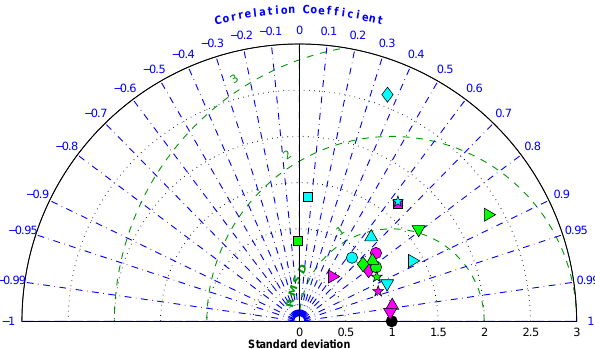
Fig. 2. Taylor diagram of non-area weighted statistical summary be- tween the simulated and observed annually averaged (climatology) of ( 5 ) ocean temperature, ( B ) salinity, ( ? ) phosphate, ( 4 ) dissolved oxygen, ( (cid:13) ) silicate, ( ♦ ) dissolved inorganic carbon, and ( (cid:3) ) al- kalinity. Shown here are comparison at surface (magenta), 1000m (blue), and 3000m (green) depths. Observations are based on the World Ocean Atlas (WOA) and GLODAP (see also text). The black circle represents the observations. All standard deviations are nor- malized to the respective observed standard deviation. For tempera- ture, salinity, phosphate, silicate and oxygen, we compare the HIST simulation from 1980–1999 period, whereas for DIC and ALK, we use the 1996–2005 simulation